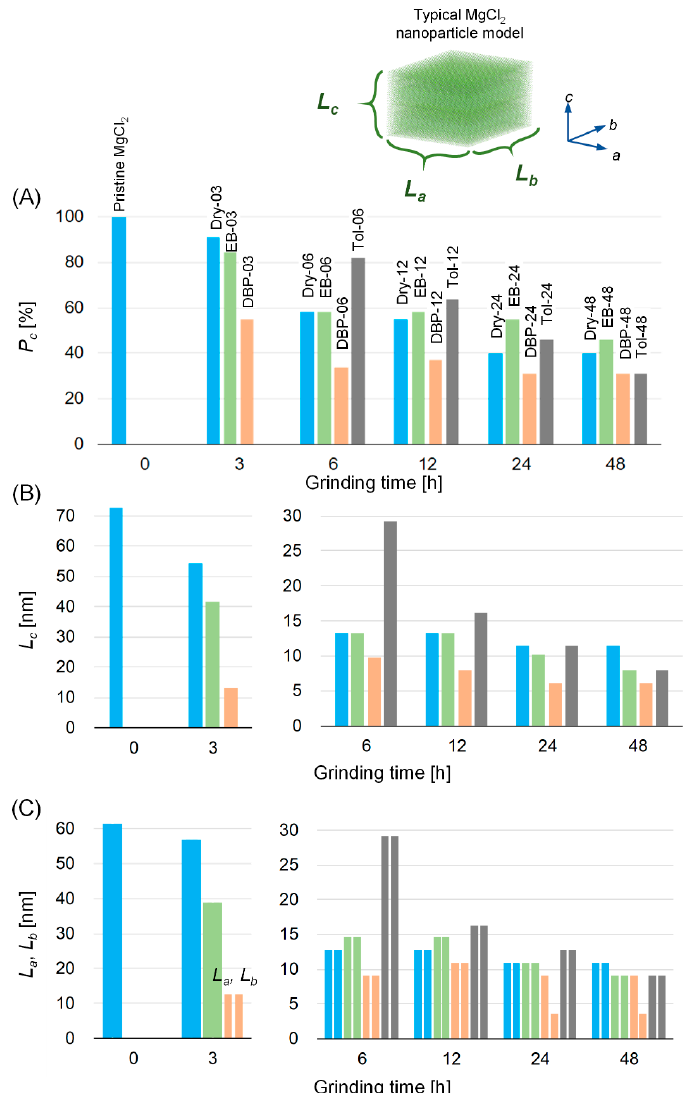
Figure 3. Development of structural disorder along with the grinding time. MgCl 2 samples ball-milled in a dry condition (blue). MgCl 2 samples ball-milled in the presence of EB (green), DBP (orange), or or toluene (gray). Four structural parameters, ( A ) P c , ( B ) L c , and ( C ) L a and L b , were determined